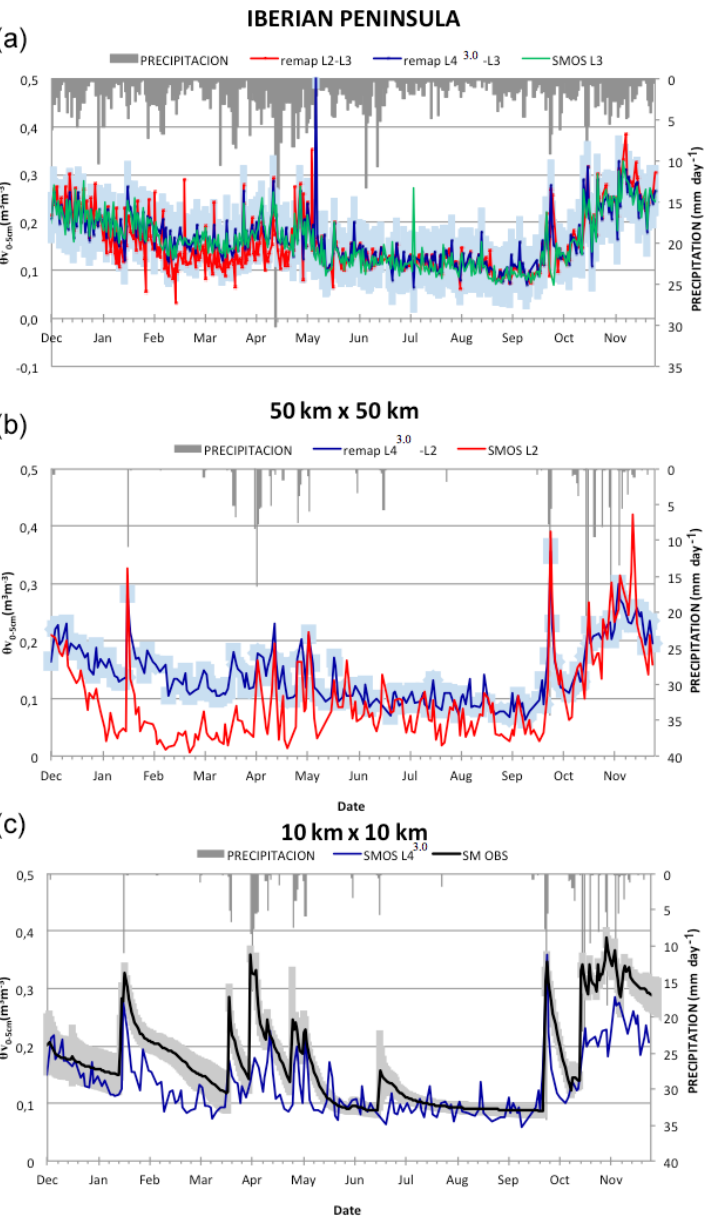
Figure 6. Temporal evolution of surface soil moisture time series averaged over the Iberian Peninsula (a) , the VAS area (50km × 50km; b ) and the OBS area (10km × 10km; c ). SMOS afternoon orbits are considered. Daily mean precipitation from the AEMET stations is shown on the top of each plot. SMOS and remapped SMOS products are indicated in the plots. Shaded areas show standard